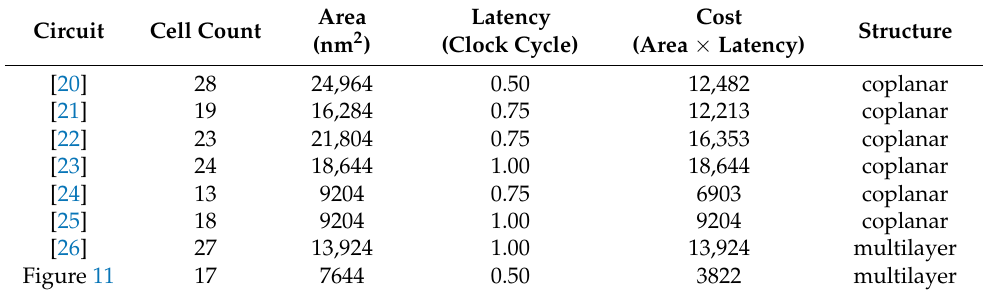
Table 6. Performance comparison of QCA D-latch.